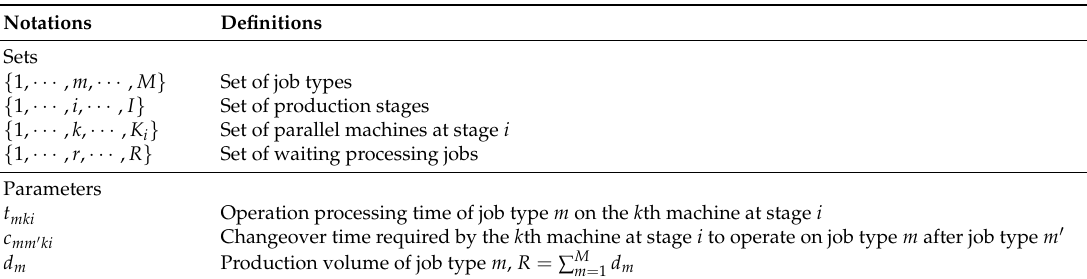
Table 1. Problem’s